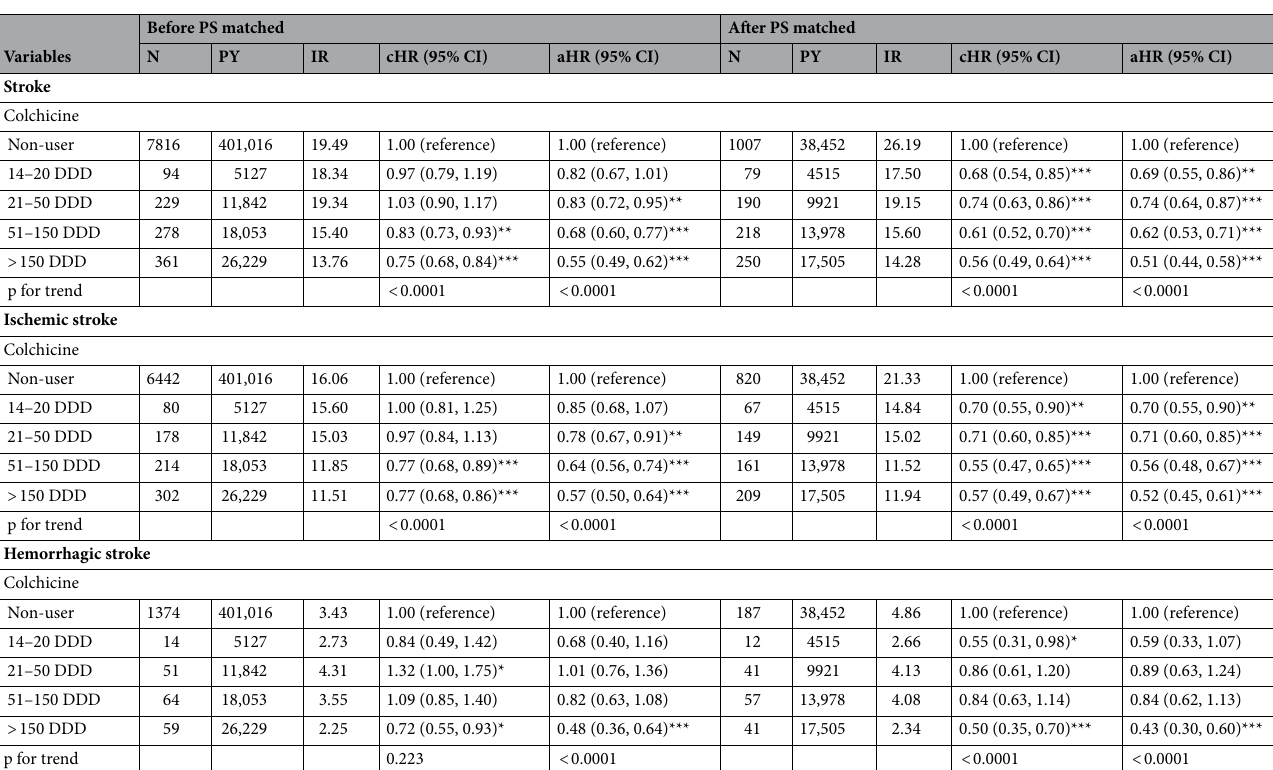
Table 3. Hazard ratio and 95% CI for stroke associated with total cumulative use of colchicine. aHR adjusted for age, sex, hypertension, hyperlipidemia, hypoglycemia, obesity, gout, pneumonia, hepatitis B, hepatitis C, liver cirrhosis, Allopurinol, Benzbromarone, nsaid, Oralsteroid, Antithrombotic, adapted Diabetes Complications Severity Index, aDCSI and inpatient day. PS, propensity score; N, number of event; PY, person-years; IR, incidence rate, per 1000 person-years; cHR, crude hazard ratio; aHR, adjusted hazard ratio; CI, confidence interval; DDD: defined daily doses; 14-20DDD: 28–40 tablets, 21-50DD:41–100 tablets, 51-150DDD: 51–300 tablets, > 150DD: > 300 tablets. *p < 0.01, **p < 0.01, ***p <